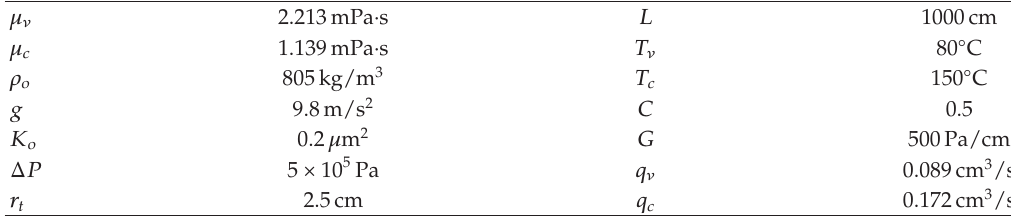
Table 1: Model parameters and